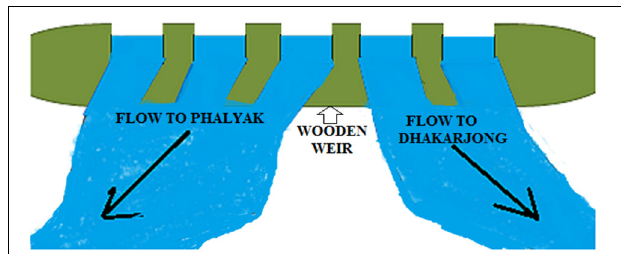
FIGURE 4 | Water distribution system made from wooden trunk used in the Upper Kaligandaki basin,